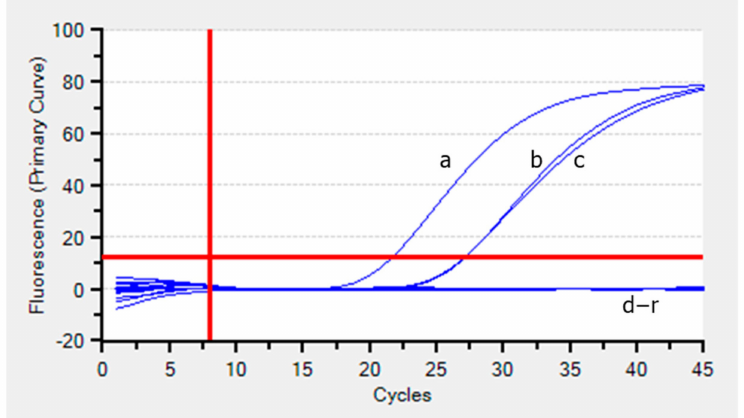
Figure 3. Analytical specificity of the TaqMan-based real-time PCR assay. a—Red sea bream iridovirus (RSIV) genotype II; b—infectious spleen and kidney necrosis virus (ISKNV) type; c—turbot reddish body iridovirus (TRBIV) type; d–r—the three viral and 12 bacterial species found in the fish (see Section 2.5.2 for pathogen